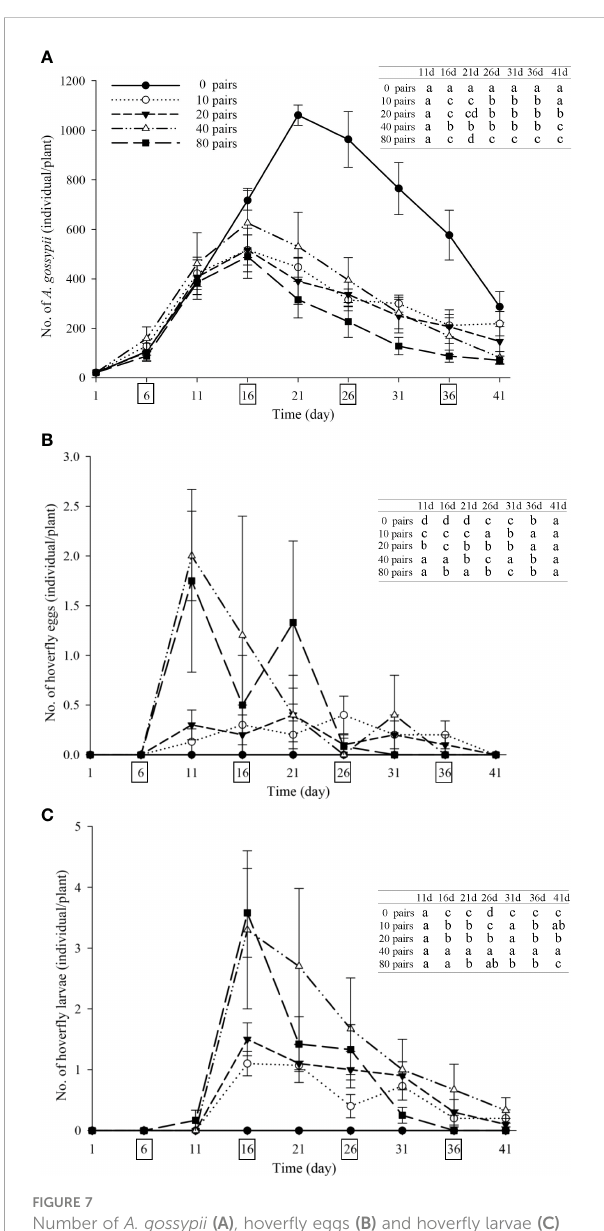
FIGURE 7 Number of A. gossypii (A) , hover fl y eggs (B) and hover fl y larvae (C) per strawberry plant over time during winter 2020-21. Four consecutive hover fl y releases were conducted (as shown by boxes on the abscissa in each fi gure). Data are plotted for different hover fl y release rates i.e., 0 (i.e., bagging treatment), 10, 20, 40 and 80 adult pairs. Different lowercase letters indicate statistically signi fi cant differences between treatment groups on the same time in each fi gure (One-way ANOVA, P <0.05, Tukey ’ s HSD post-hoc